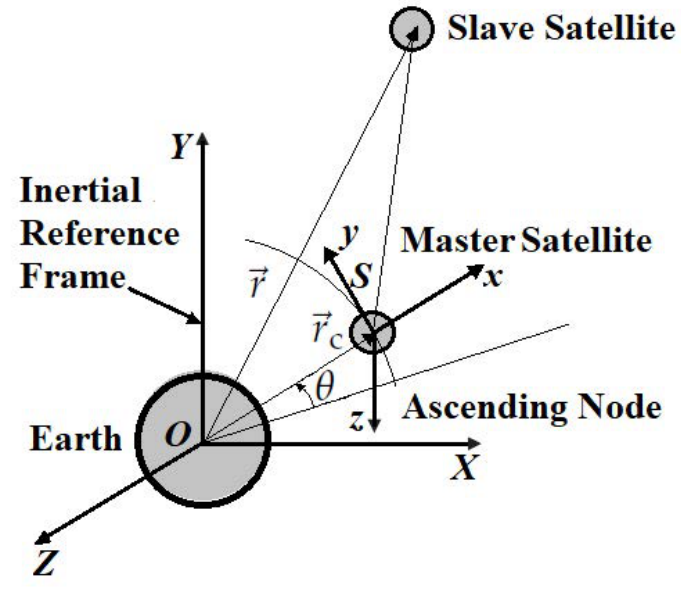
Figure 1. Reference